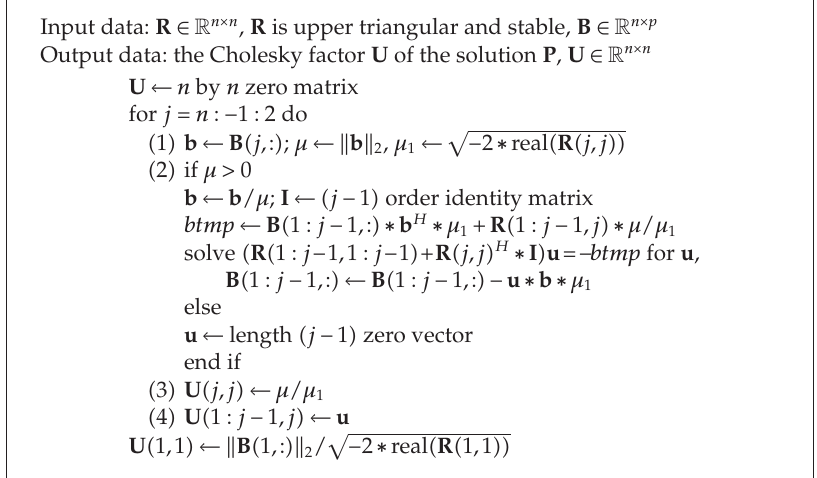
Algorithm 3.1 . Modified Hammarling’s algorithm using